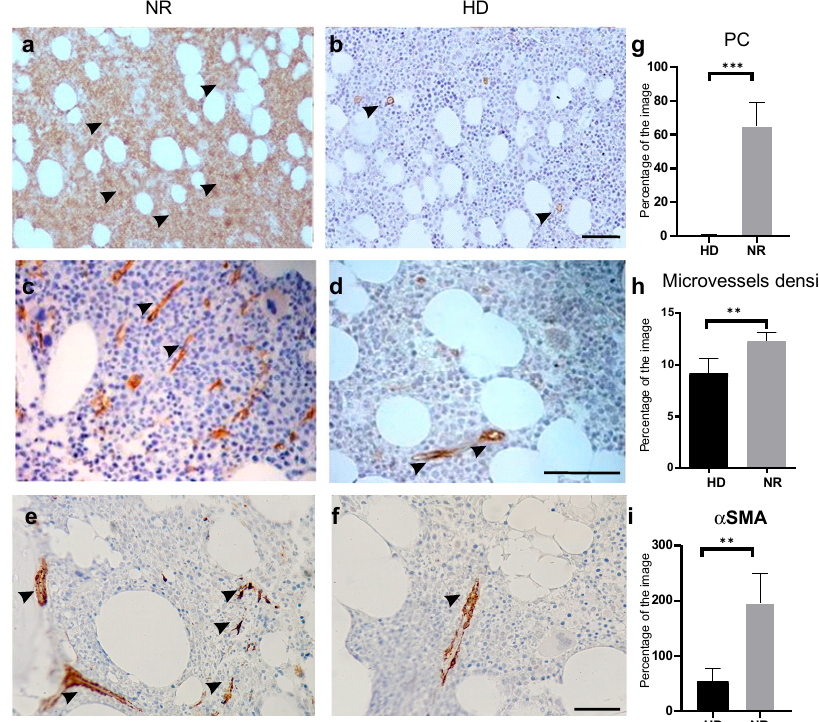
Figure 1. Histopathological examination of BM from HD and NR patients. ( a , b ) IHC detection of PC (brown color) in BM of NR patient ( a ) and HD ( b ) with an antibody against CD138. ( c , d ) IHC detection of microvessels (brown color) in BM of NR patient ( c ) and HD ( d ) with an antibody against CD34. ( e , f ) IHC detection of α -SMA+ cell (brown color) in BM of NR patient ( e ) and HD ( f ). The scale bar–100 µm. ( g – i ) Quantifications of corresponding IHC. The percentage of the images’ area covered by the IHC staining is plotted on Y-axis. The data are shown as mean ± SD. ** p < 0.01, *** p < 0.001. Abbreviations: BM = bone marrow; HD = healthy donors; NR = non-responder; PC = plasma cells, IHC = immunohistochemical staining. Arrows are pointing the areas of positive staining.